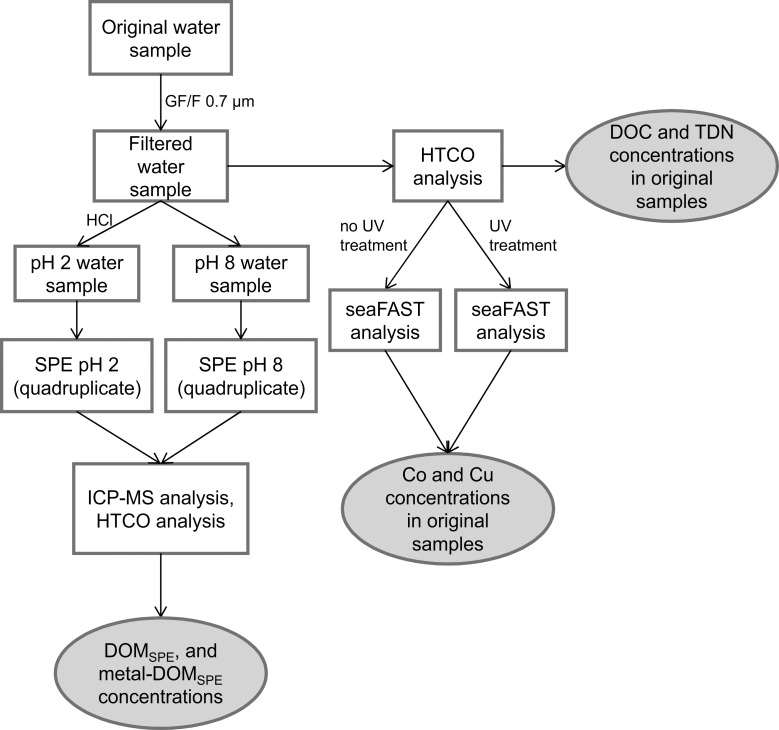
Sample processing workflow.The sample processing steps are represented as white boxes. Measured parameters are specified in grey boxes. DOC and total dissolved nitrogen (TDN) in original water samples were analyzed by high temperature catalytic oxidation (HTCO). The seaFAST analysis was used to determine Co and Cu concentrations in the original filtered water samples. Aliquots of original filtered water samples were solid-phase extracted in quadruplicates for each acidified and non-acidified sample. DOC and DON in solid-phase extracts (DOCSPE, DONSPE) were analyzed by HTCO. All other elements were analyzed by inductively coupled plasma mass spectrometry (ICP-MS).